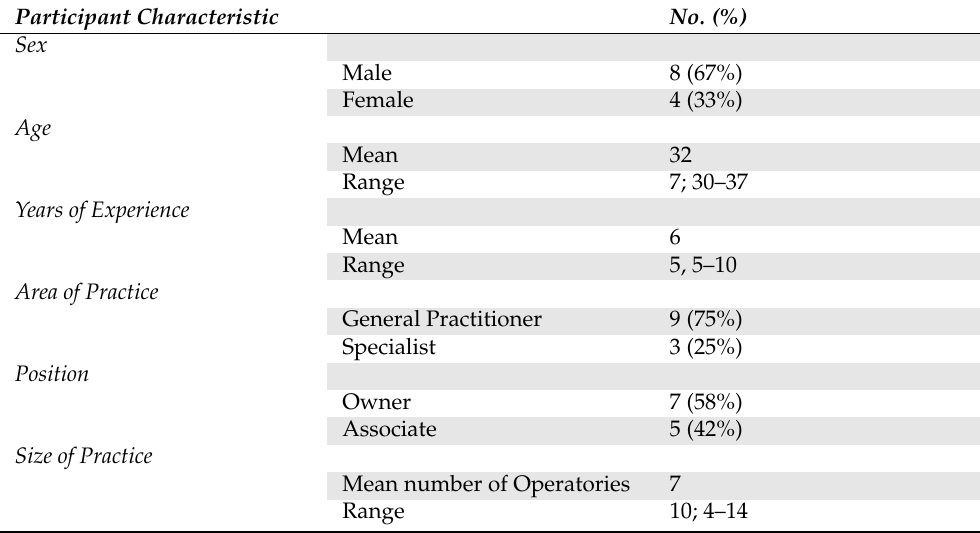
Table 1. Summary of Study Participant Characteristics.